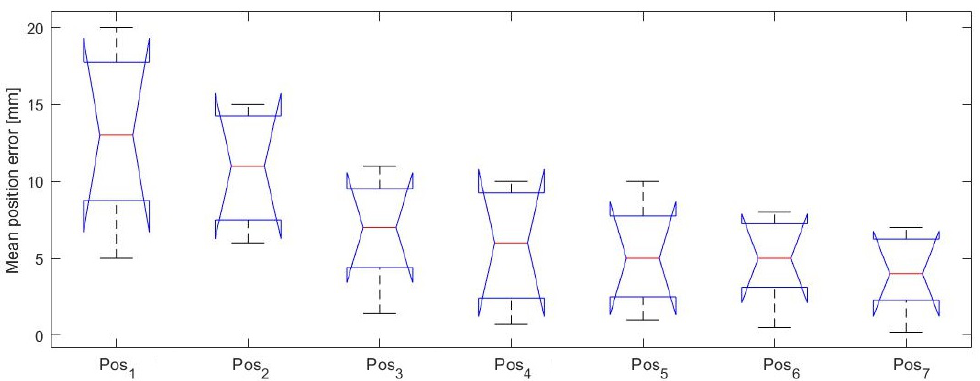
Figure 10. Box diagram for measured location positions taken in Figure 9b. Source: